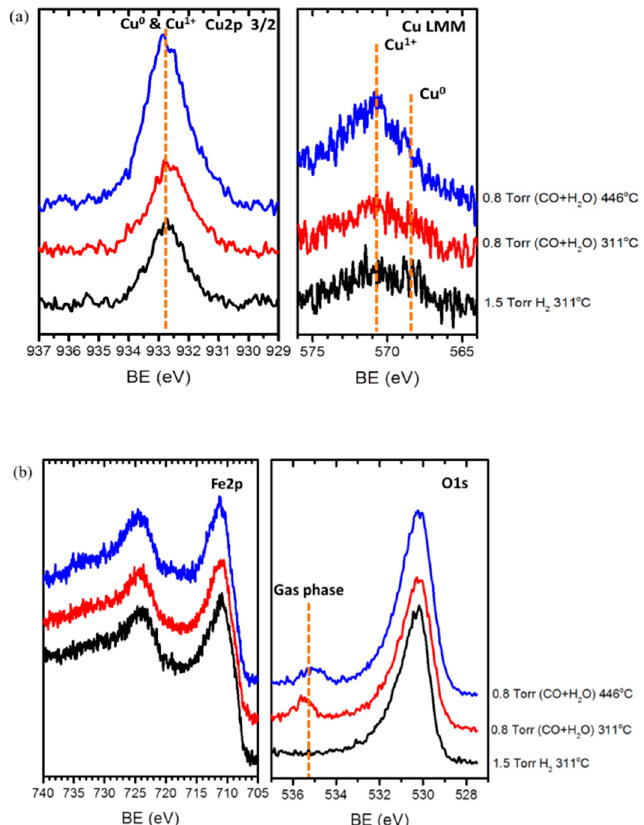
Figure 7. Ambient pressure X-ray photoelectron spectrometer (AP-XPS) studies of ( a ): the Cu 2p3/2, Cu LMM of the Cu 1 Fe 9 O x nanorod sample and ( b ): Fe 2p, O1s of the rod catalyst under the WGS reaction conditions.